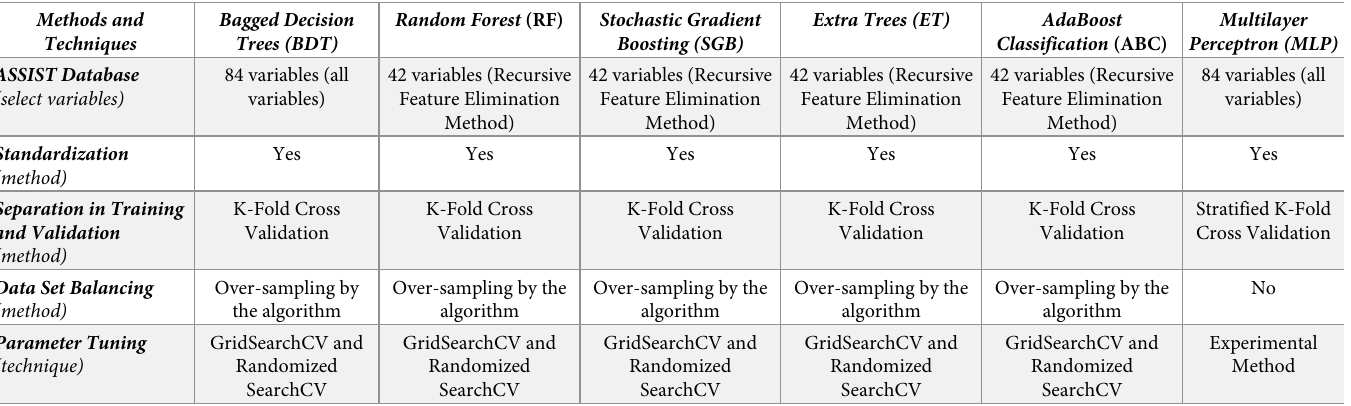
Table 2. Summary of methods and